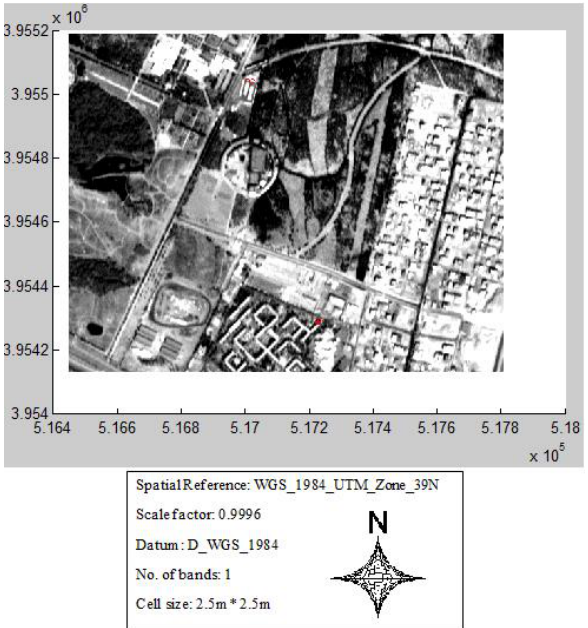
Figure 5. The second geo-referenced image of the study area acquired at October 3, 2010